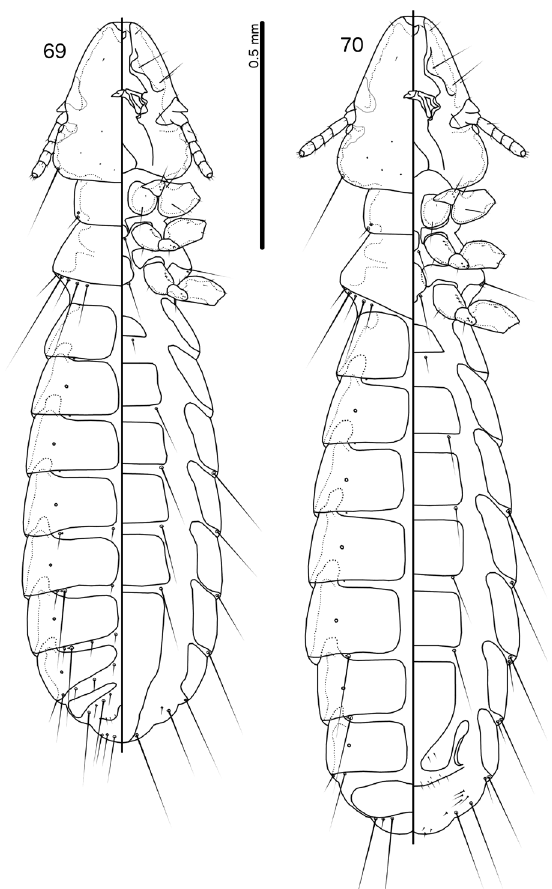
Figures 69, 70. Brueelia matvejevi Balát, 1981, ex Turdus viscivorus Linnaeus, 1758 69 Male habitus, dorsal and ventral views 70 Female habitus, dorsal and ventral views.